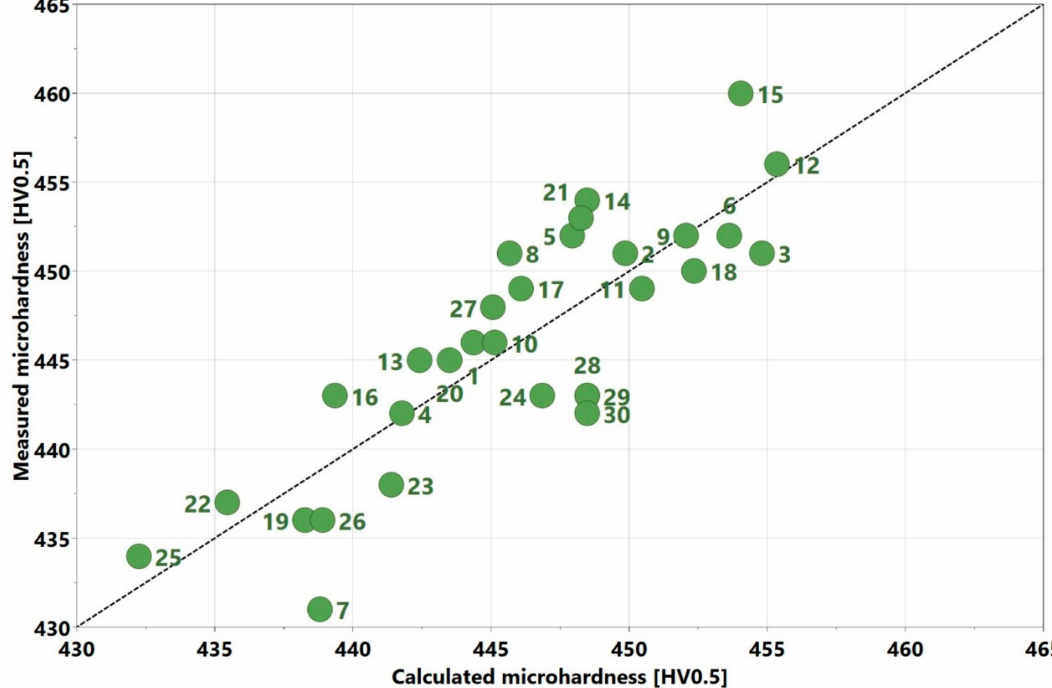
Figure 19. Comparison of experimentally measured microhardness to the calculated values from the regression